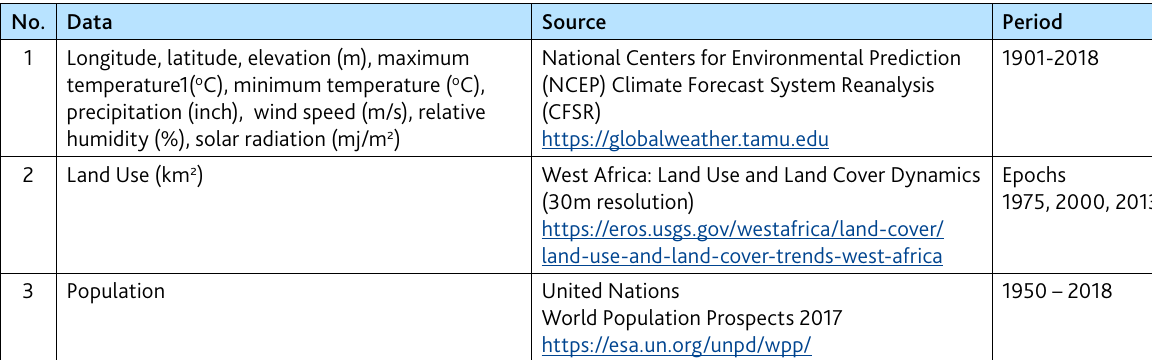
Table 1. Data and Sources No. Data